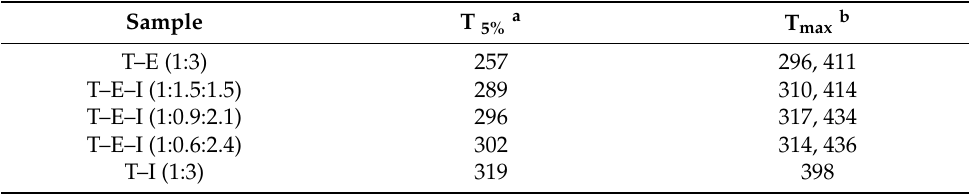
Figure 6. Results of TGA analysis of polyHIPEs: ( a ) weight loss vs. temperature, ( b ) derivative curves versus temperature. Table 2. Thermogravimetric data of the thermal degradation of obtained polyHIPEs. Sample